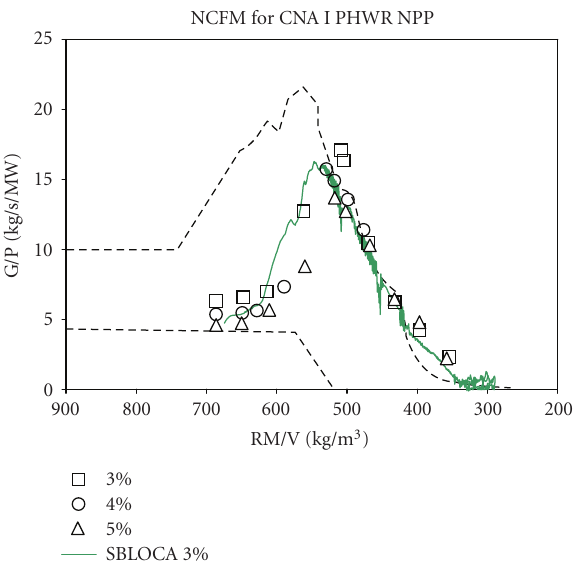
Figure 5: Natural circulation map for the PSB-VVER experimental and calculated